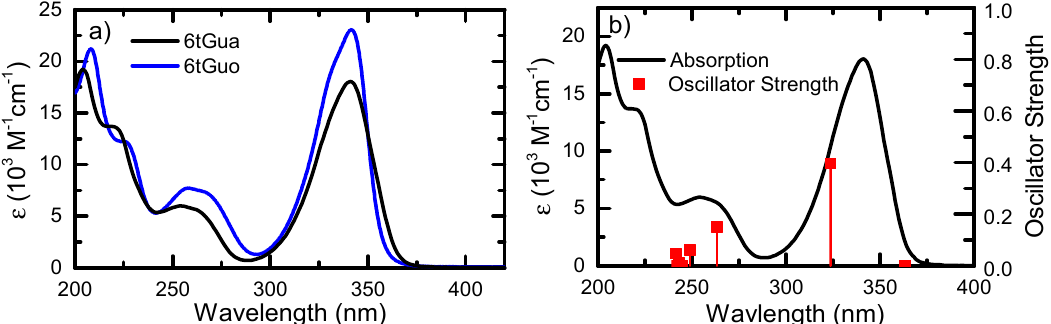
Figure 2. ( a ) Ground-state absorptivity of 6tGua and 6tGuo in PBS pH 7.4; ( b ) Ground-state absorptivity spectrum of 6tGua in PBS plotted with oscillator strengths calculated at the TD-PBE0/IEFPCM/6-311++G(d,p) level of theory. Vertical excitation energies were redshifted by 0.15 eV relative to those reported in Table 1 to better match the experimental absorptivity spectrum.